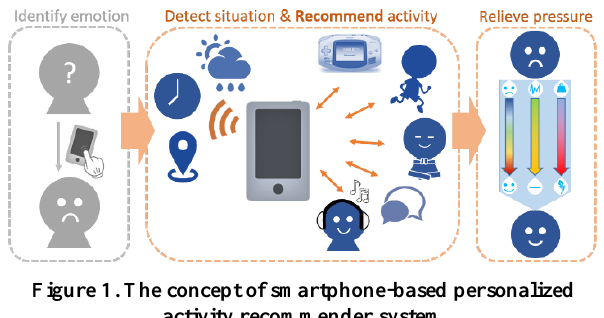
Figure 1. The concept of smartphone-based personalized